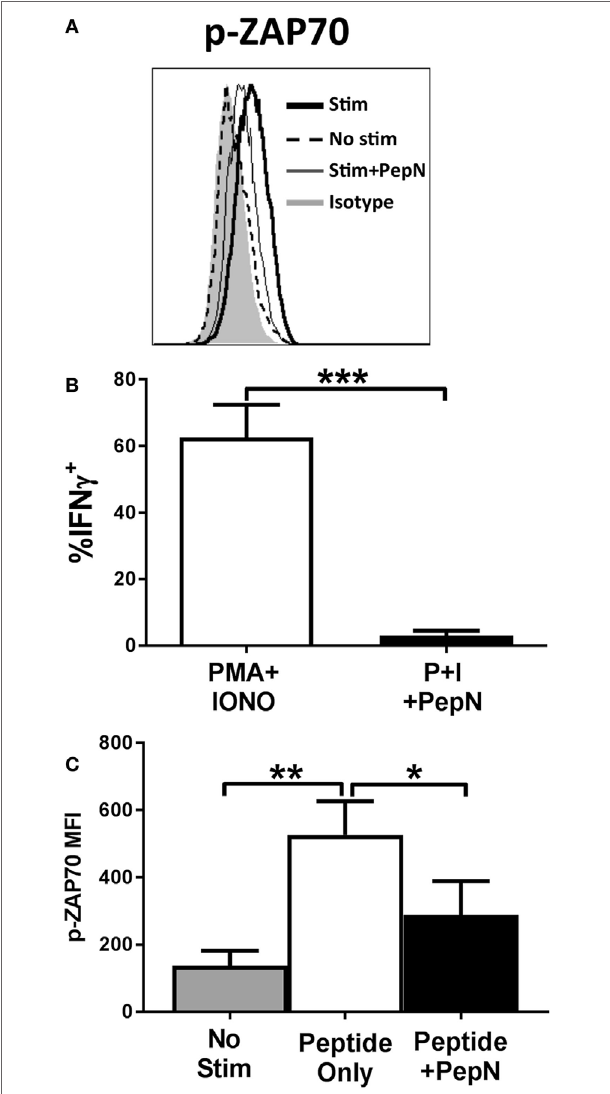
FigUre 8 | NP-specific cytotoxic T lymphocyte (CTL) treated with purified aminopeptidase N (PepN) show diminished ZAP-70 phosphorylation following peptide stimulation which cannot be restored by stimulation with phorbol 12-myristate 13-acetate (PMA) and ionomycin. NP-specific CTL were stimulated with splenocytes pulsed with 10 − 6 M NP 147–155 peptide in the presence or absence of PepN. Following stimulation, cells were fixed with 2% paraformaldehyde to halt TCR signaling. Permeabilized cells were stained with anti-p-ZAP-70 antibody. Representative histograms (a) and averaged data from four independent experiments (b) are shown. (c) NP-specific CTL was stimulated with PMA and ionomycin in the presence or absence of PepN. IFN γ production under each condition is shown. Data shown are the mean ± SEM from four to seven independent experiments utilizing at least two independently generated CTL lines. * p < 0.05, ** p < 0.01, and *** p <